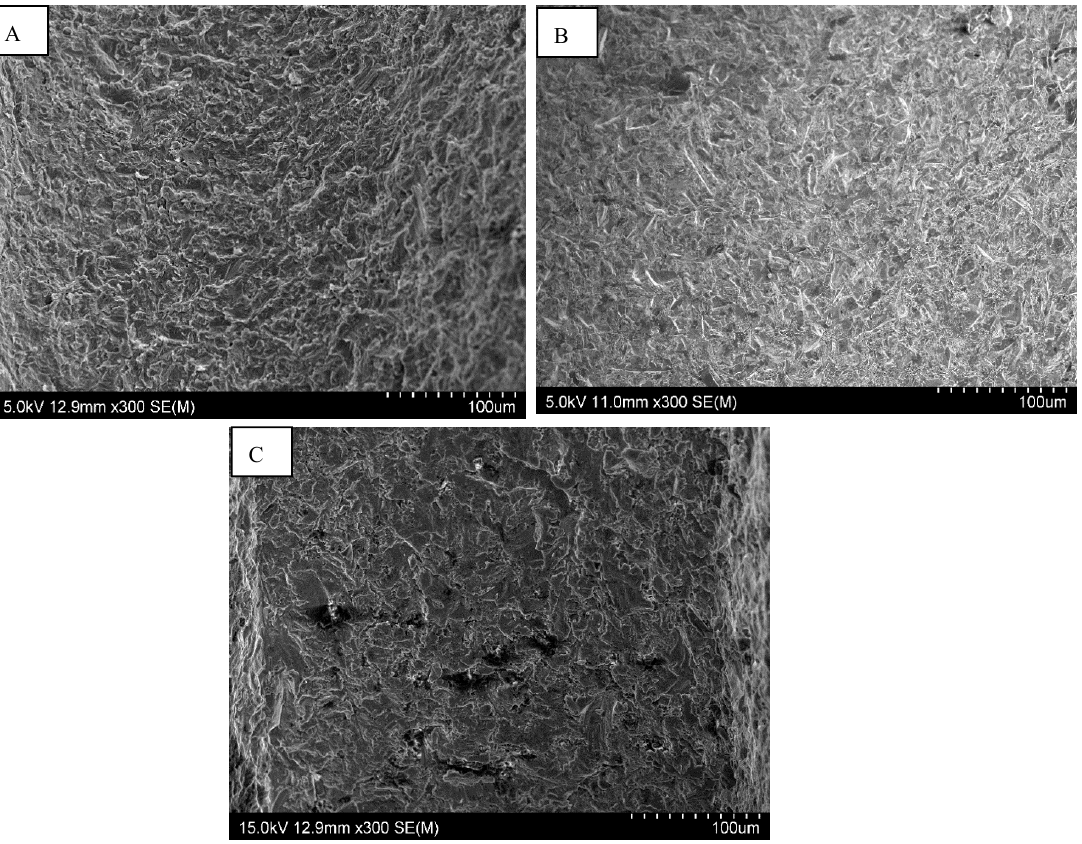
Figure 2. SEM image of the surface morphology of the Tekka Inkone ® implant showing a regular surface: magnification ×300 ( A ) and ×2500 ( B ).